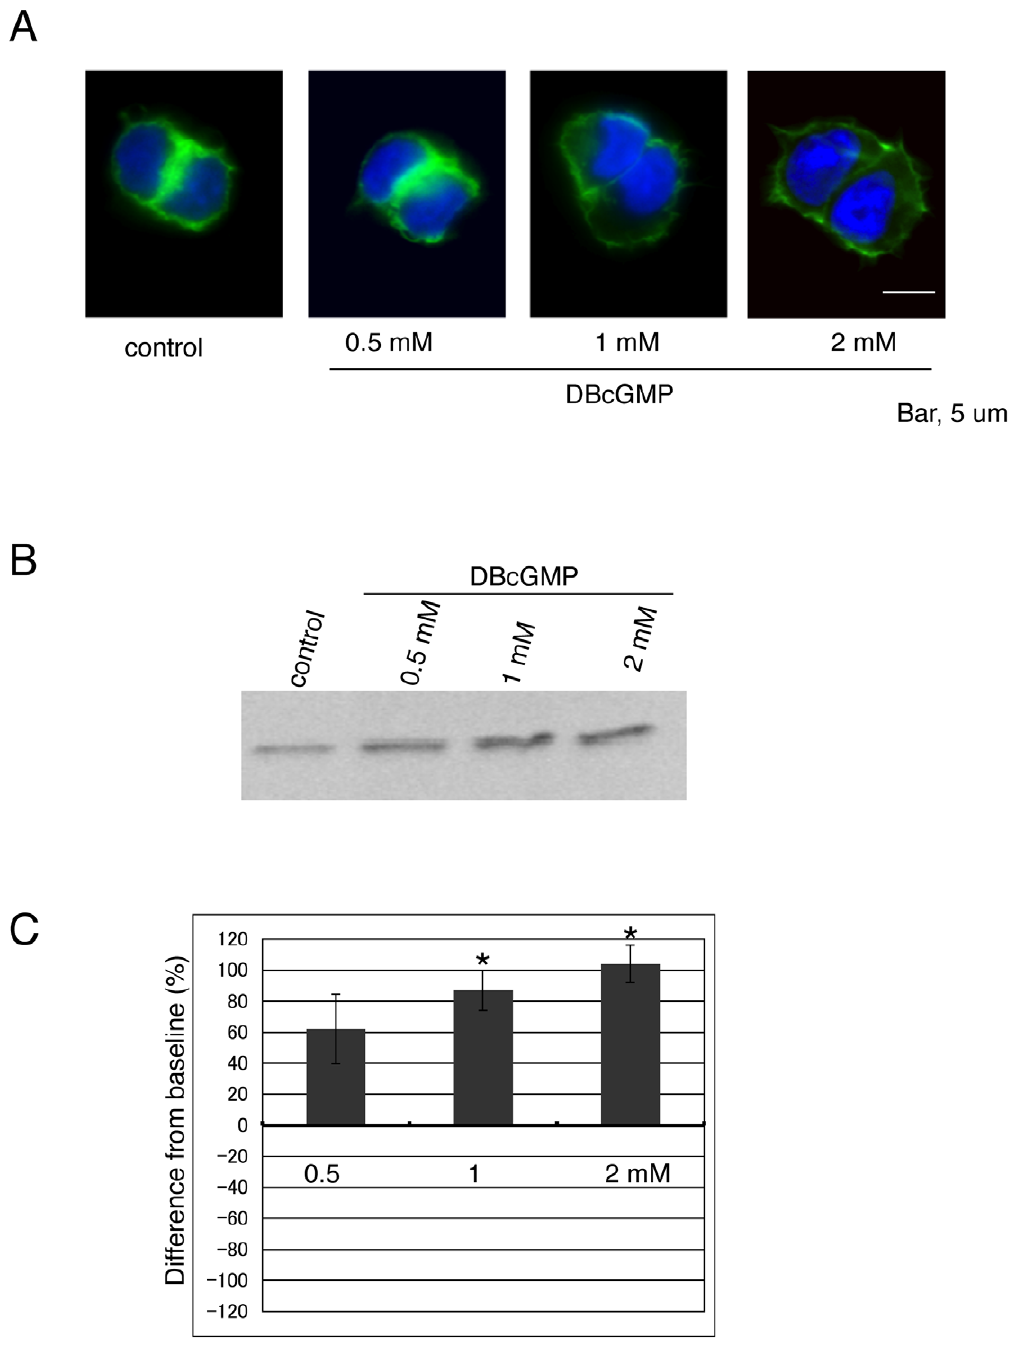
Figure 7. DBcGMP enhances retinoschisin secretion and modifies F-actin localization. (A) Effects of DBcGMP on the F-actin cytoskeleton. Weri-Rb1 cells were cultured with medium alone (untreated control) or the indicated concentrations of DBcGMP for 72 h. Cells were then fixed and labeled with Alexa Fluor 488-phalloidin (green). Note the F-actin protrusions in cells treated with 1 mM and 2 mM DBcGMP. Bar, 5 m m. (B) Retinoschisin secretion into the medium increases with the three concentrations of DBcGMP used to treat the cells for 72 h, as seen on the Western blot of the media samples reacted with the RS24-37 antibody.(C) Quantification of theretinoschisin bandson the Western blot in (B)(see MATERIALSAND METHODS). The data are means 6 SEM of three different biological samples for each condition. Retinoschisin levels in the culture medium of cells treated with the different concentrations of DBcGMP are all higher than in the medium of untreated cells, but the results are statistically significant only for the cells treated with 1 and 2 mM DBcGMP. *: p , 0.05 was obtained for the difference between DBcGMP-treated and untreated cells.